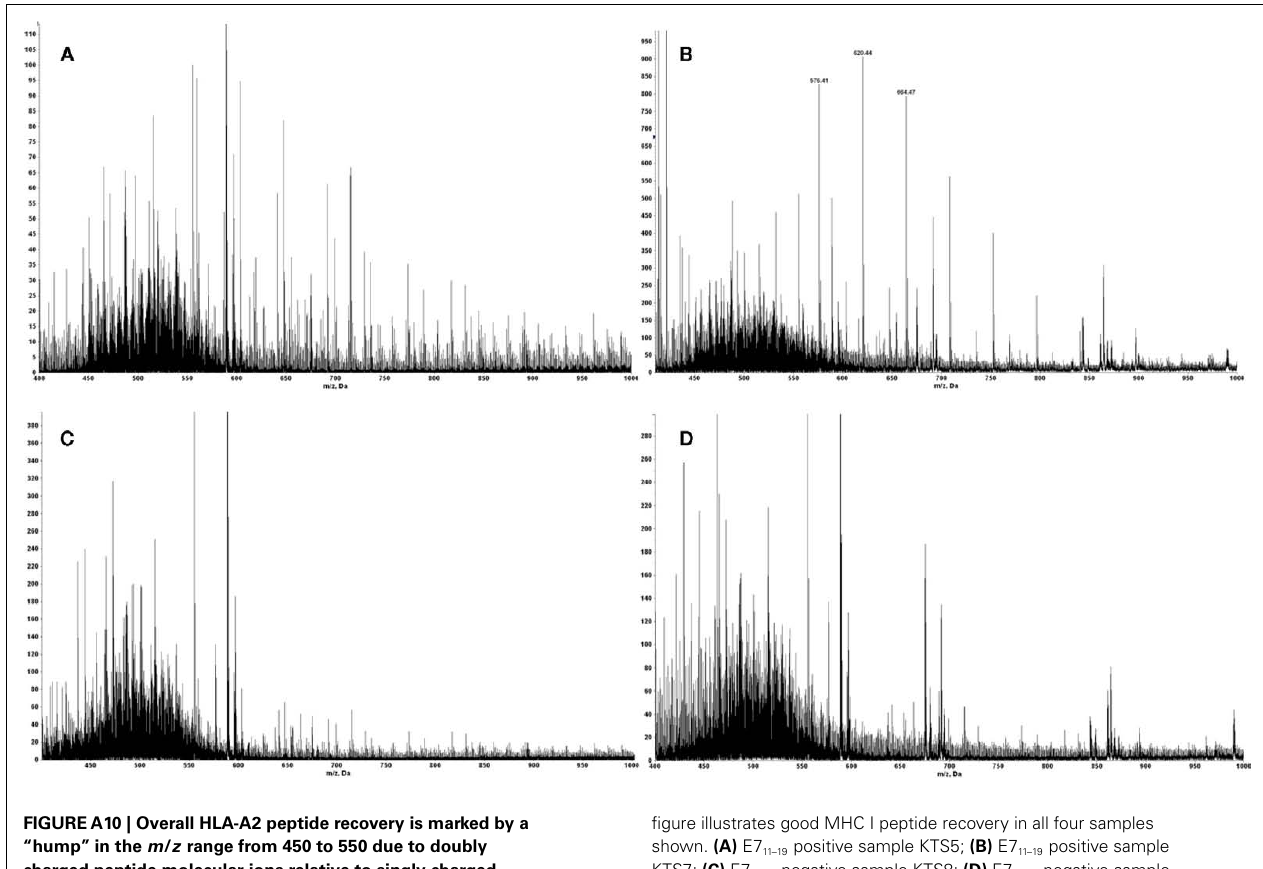
figure illustrates good MHC I peptide recovery in all four samples shown. (A) E7 11–19 positive sample KTS5; (B) E7 11–19 positive sample KTS7; (C) E7 11–19 negative sample KTS8; (D) E7 11–19 negative sample